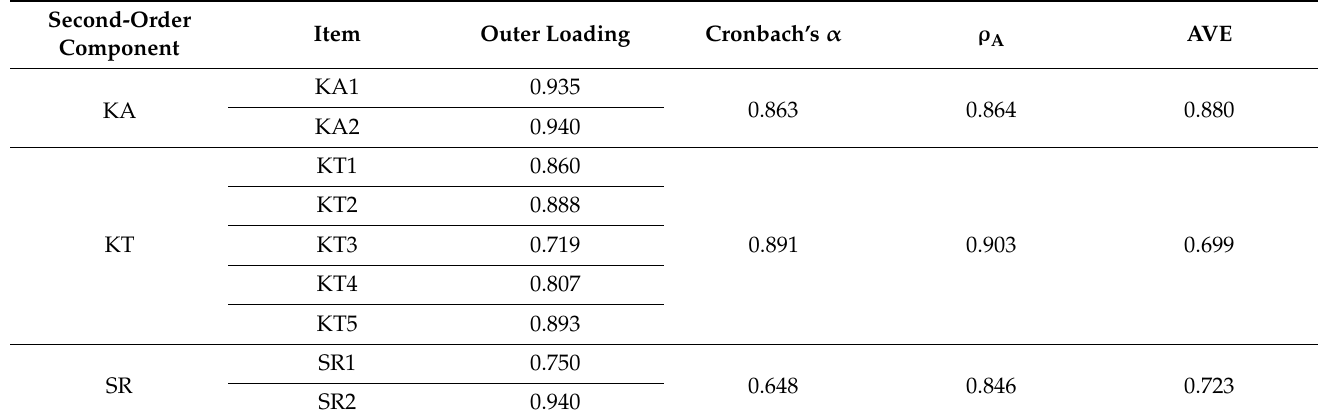
Table 4. Reliability and validity assessment of the second-order components.